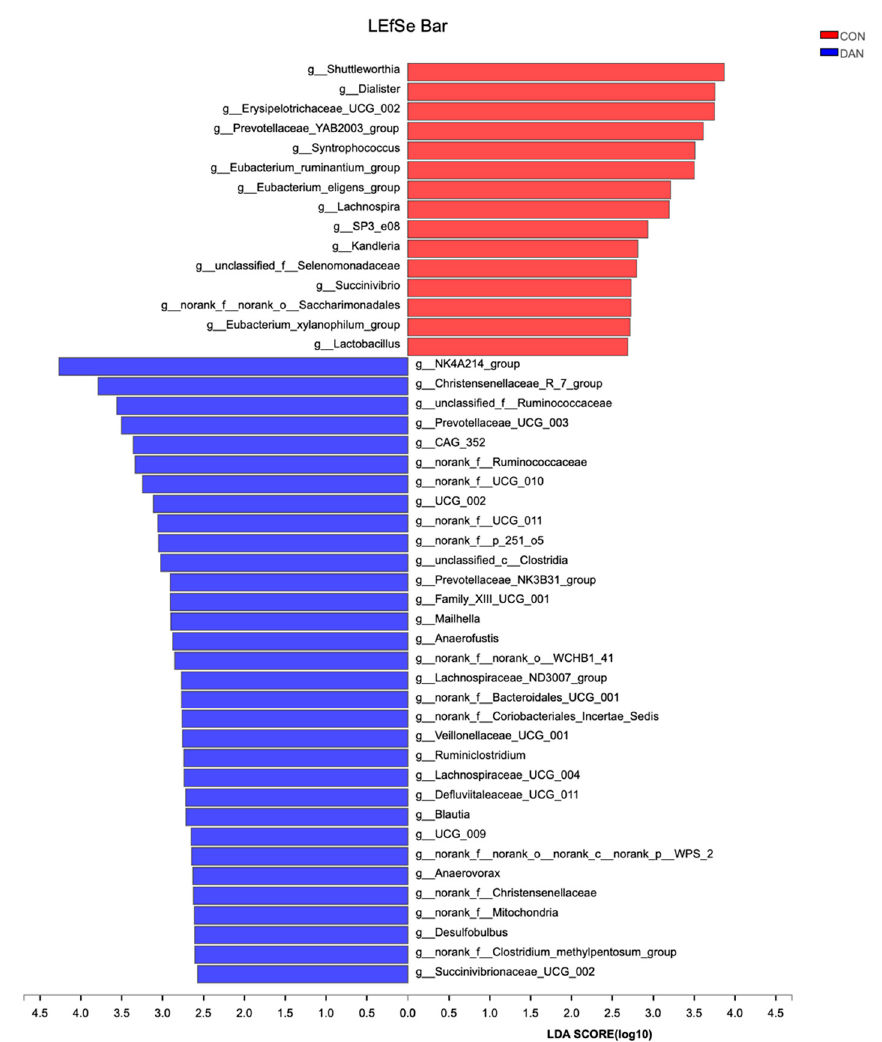
Figure 3. The rumen fluid bacteria showing the different abundance of values between the dandelion (DAN) and control (CON) groups. Red and blue bars represent the bacterial community of DAN with a significantly lower and higher abundance compared with that in the CON group, re- spectively.